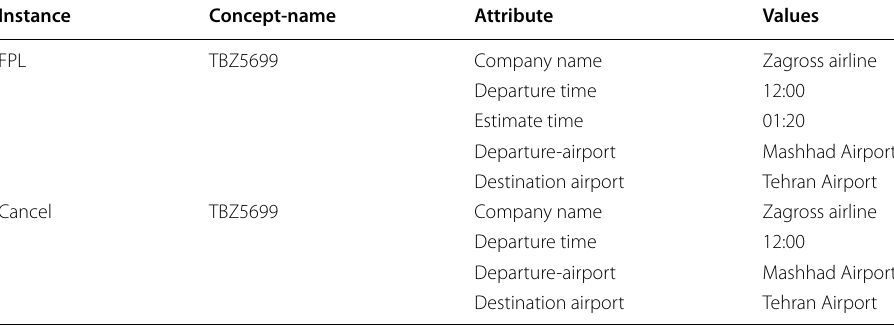
Table 8 FPL and CNL example for TBZ5699